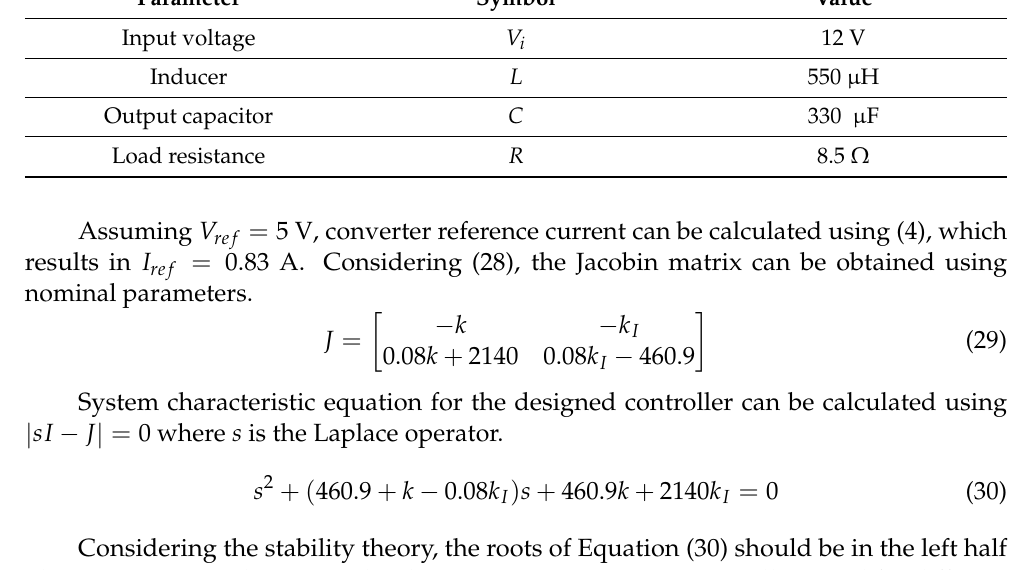
Table 1. Nominal parameters of the buck/boost DC-DC converter.